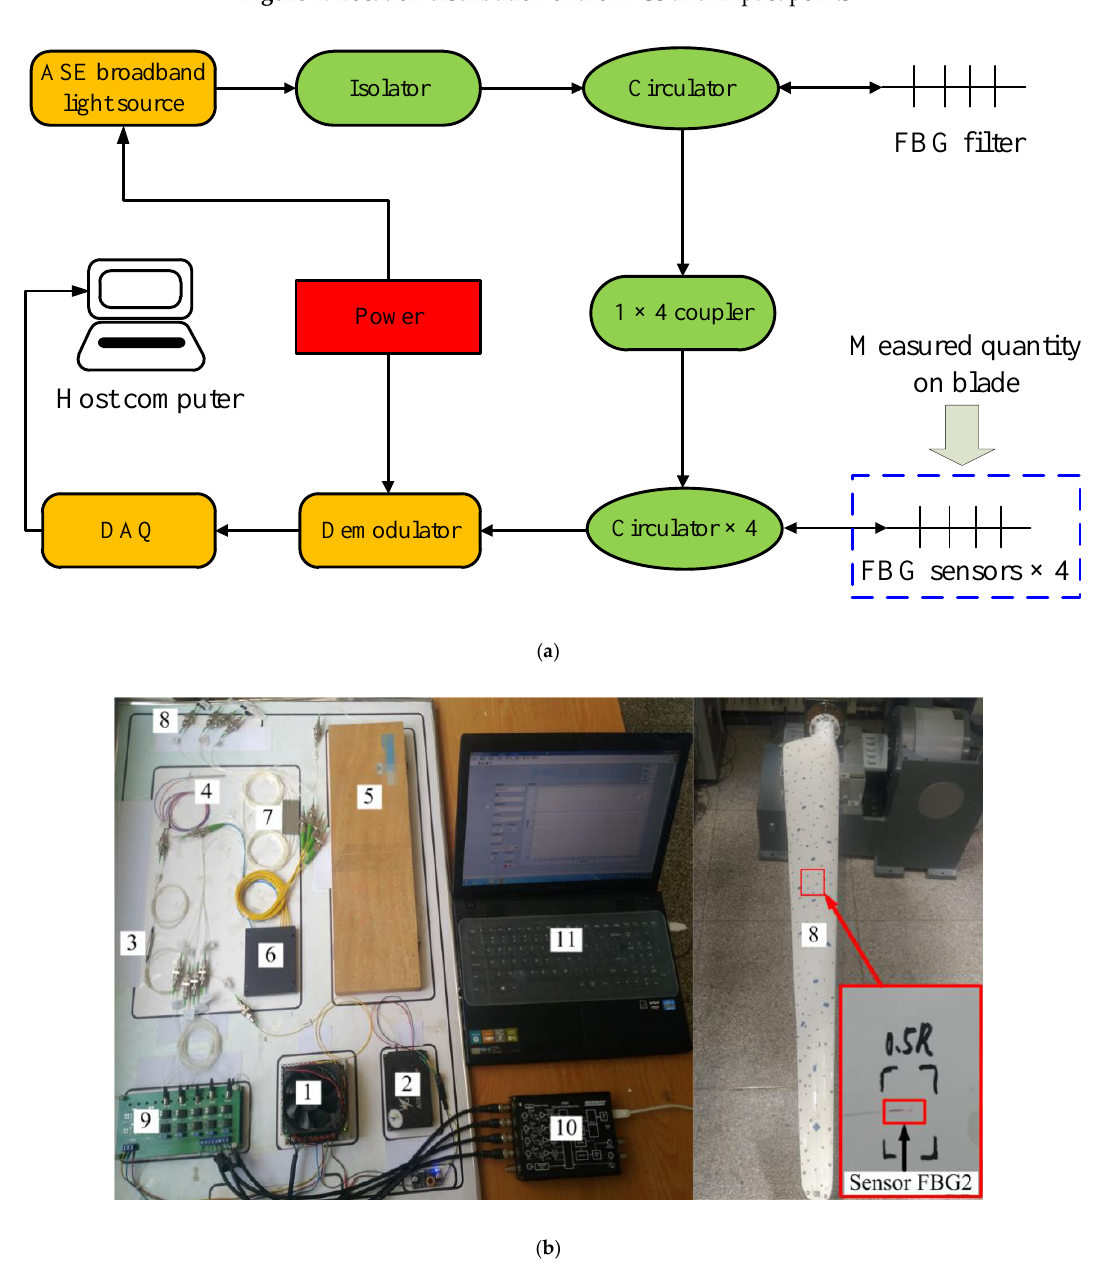
Figure 5. ( a ) FBG detection systems; ( b ) Experimental set-up. 1 — power; 2—Amplified Spontaneous Emission broadband